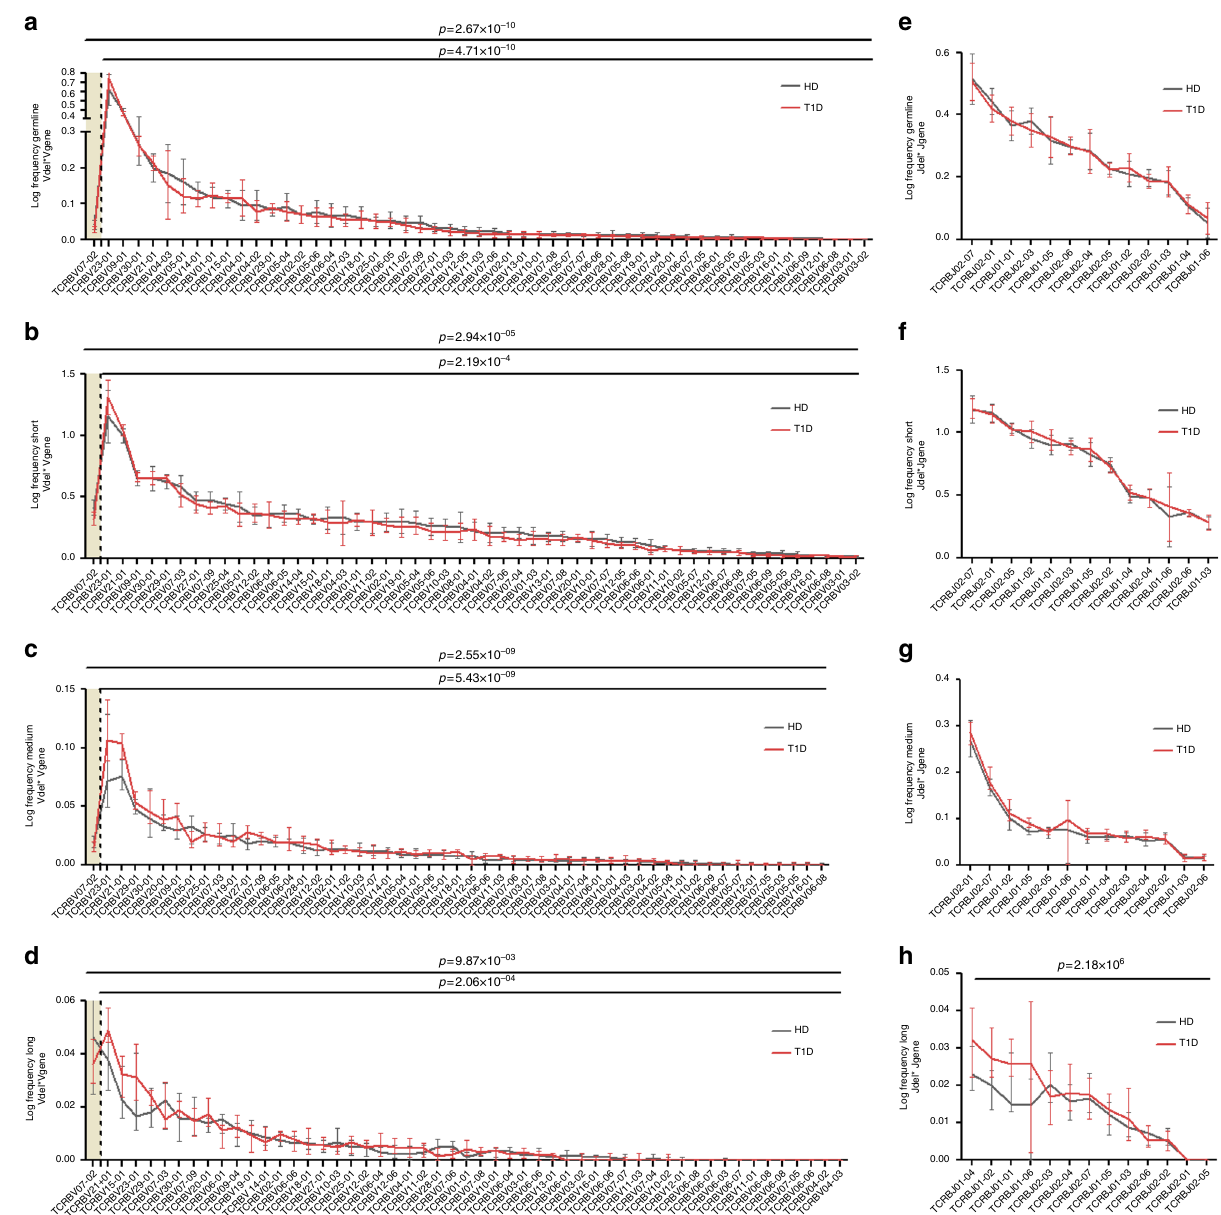
Fig. 6 Alterations in deletion patterns in patients are found in most V and J genes. Frequency of germline a , e , short b , f , medium c , g or long d , h deletions for each of the V genes ( a – d ) and J genes ( e – h ) in type 1 diabetes (T1D) patients and healthy donors (HD). The gray shaded area represents V genes that are differentially used in patients versus controls (Supplementary Fig. 14). The increased deletions pattern of T1D patients is seen both in under- represented and equally used genes. The statistical test was performed for all genes or just for those equally used in T1D and healthy donors (i.e., without those genes included in the shaded areas). Mixed effects two-way ANOVA with individual as random variable. Lines represent the mean ±